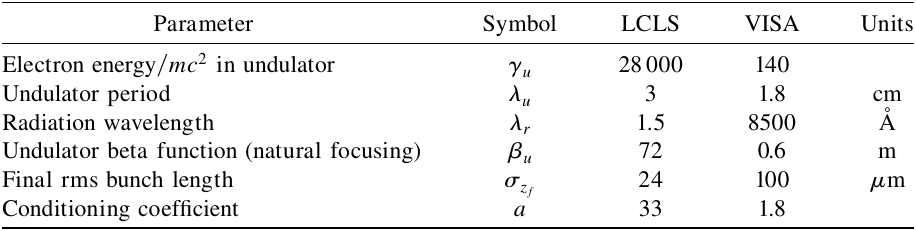
TABLE I. FEL and conditioner parameters for the LCLS [1] and for VISA [9].